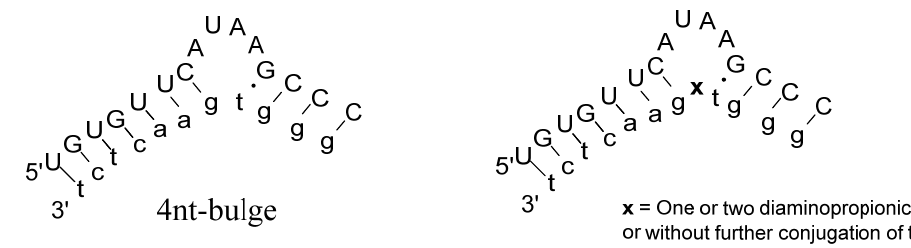
Figure 1. Left panel: A tetranucleotide RNA-bulge (upper case letters) formed by incomplete base pairing upon binding to a partially complementary PNA-strand (lower case letters). Right panel: A tetranucleotide RNA-bulge (upper case letters) formed upon binding to a partially complementary PNA-strand with one or two amino acids ( x )